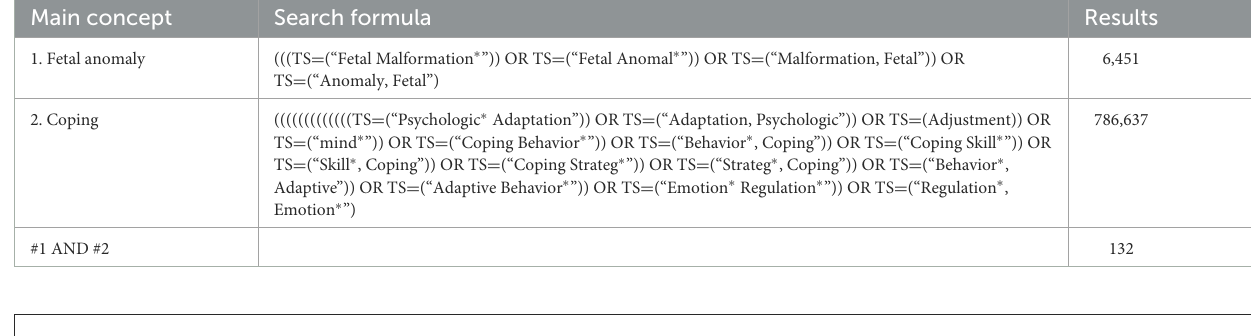
TABLE 1 Example of search strategy Web of science.